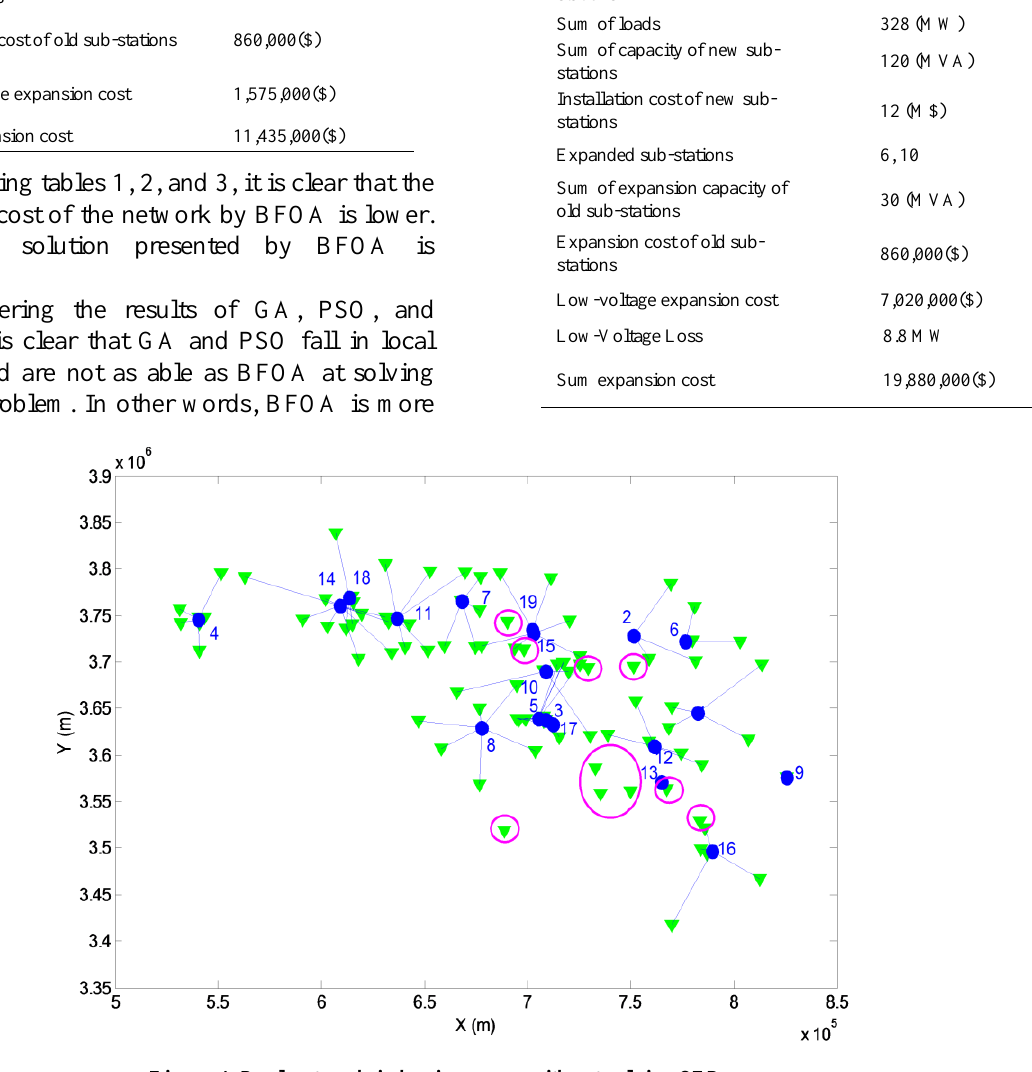
Figure 4. Real network in horizon year without solving SEP.